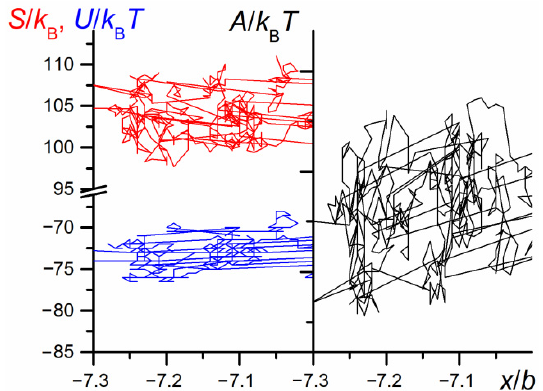
Figure 17. The entropy, S , internal energy, U , and Helmholtz free energy, A , profiles obtained from the simulation ( N = 100, ε PP / k B T = − 1 and 0 for P1 and P2, respectively, D = 3 b ). The chart is based on the data recorded at each elementary step, t E .